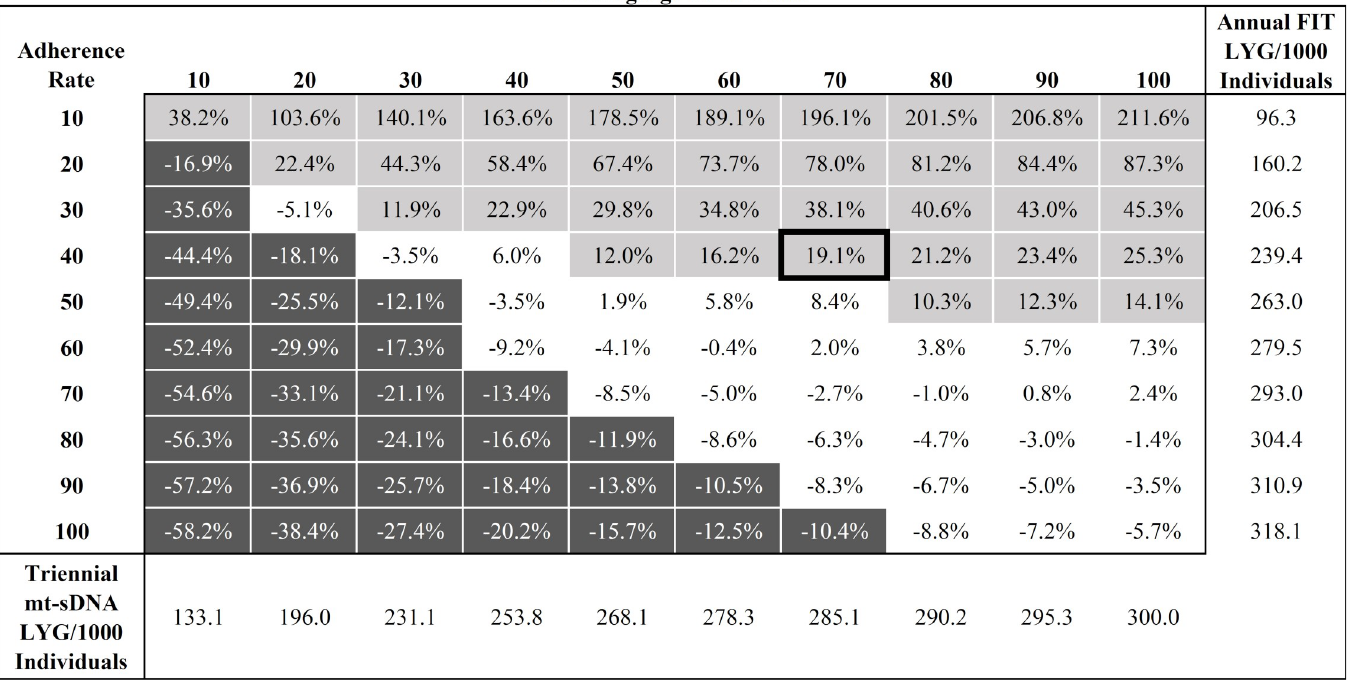
Fig 1. Percent difference in predicted Life-Years Gained (LYG) per 1000 individuals by adherence rate for triennial multitarget stool DNA (mt-sDNA) versus annual Fecal Immunochemical Test (FIT) in individuals free of diagnosed colorectal cancer at age 40 and screened between ages 50–75 years. White boxes indicate < 10% difference between tests. Light gray boxes indicate � 10% positive difference with mt-sDNA versus FIT. Dark gray boxes indicate � 10% negative difference with mt- sDNA versus FIT. Outlined box indicates base-case imperfect adherence rates.